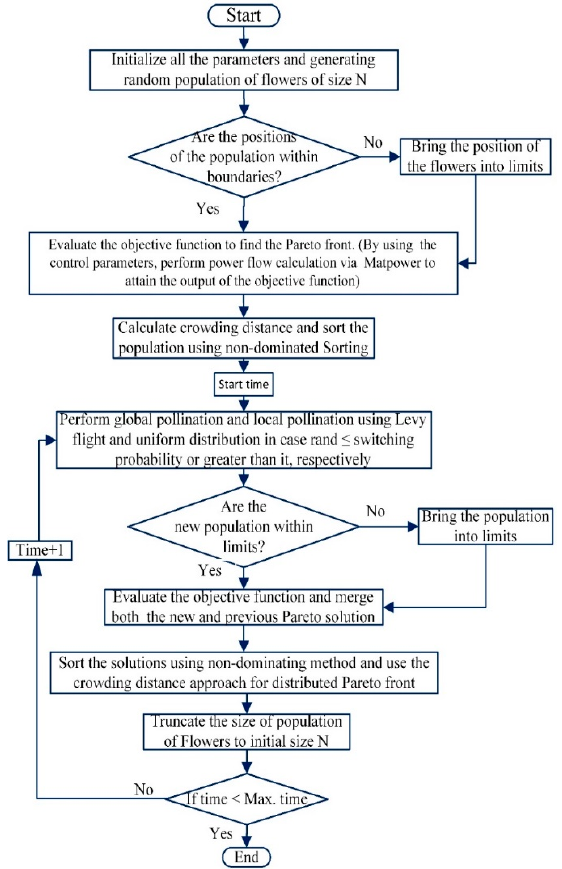
Figure 8. Flowchart of multi-objective flower pollination algorithm (MOFPA) [46].